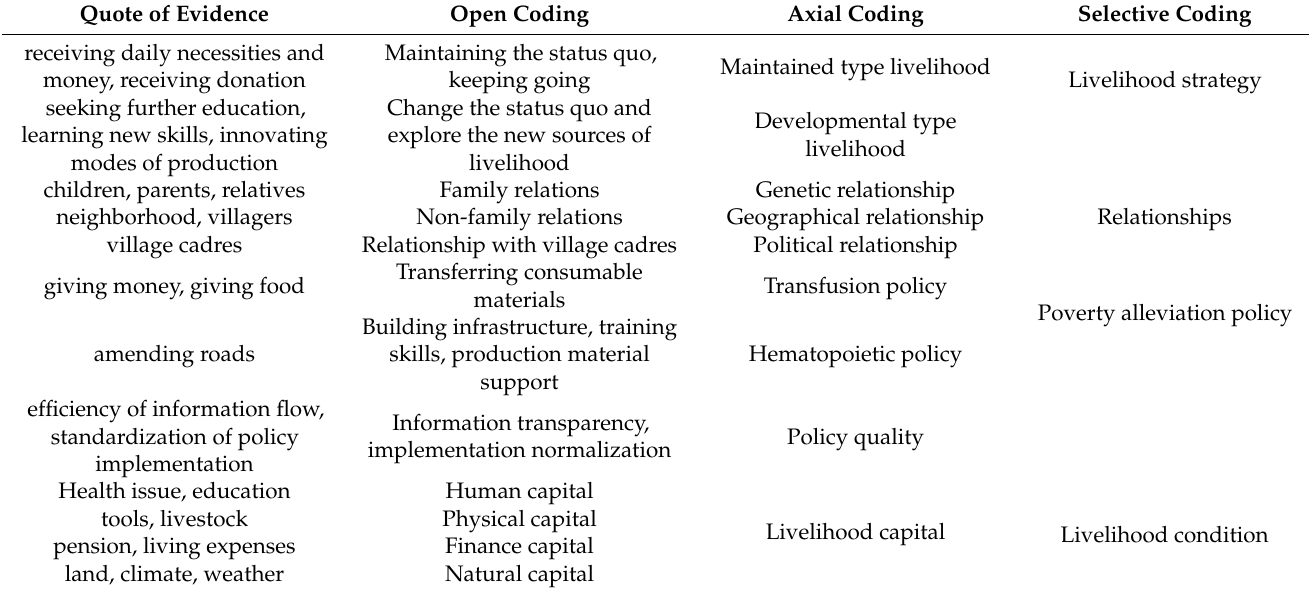
Table 3. The Coding